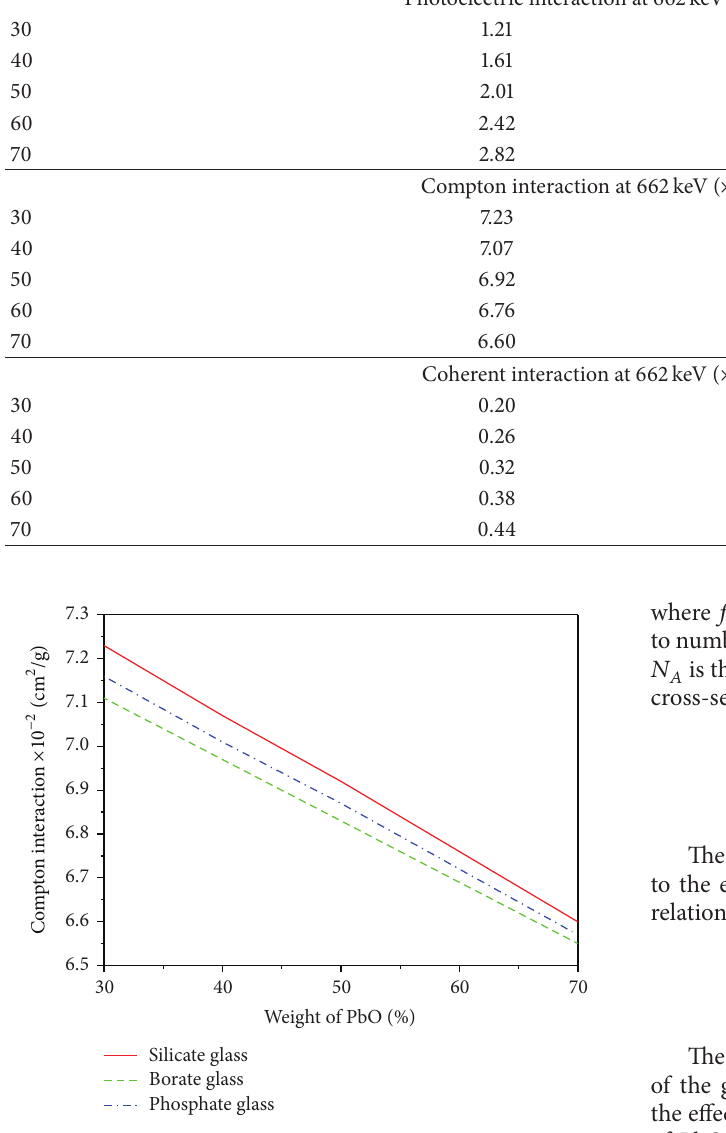
Figure 1: The Compton scattering interaction of PbO containing silicate, borate, and phosphate glass systems at 662